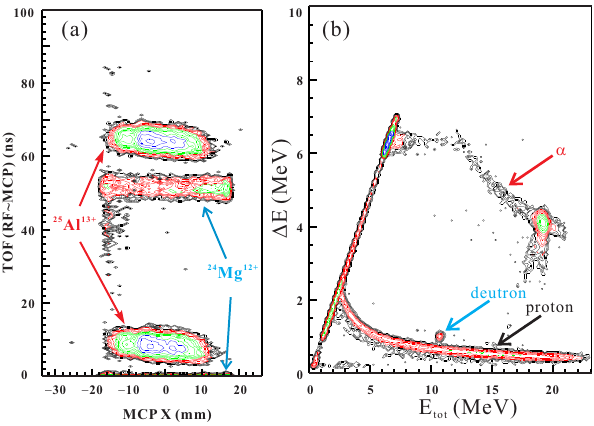
Figure 2. (a) Identification plot for the beams via the ToF technique. (b) Identification plot for the recoiling particles via the ∆ E-E